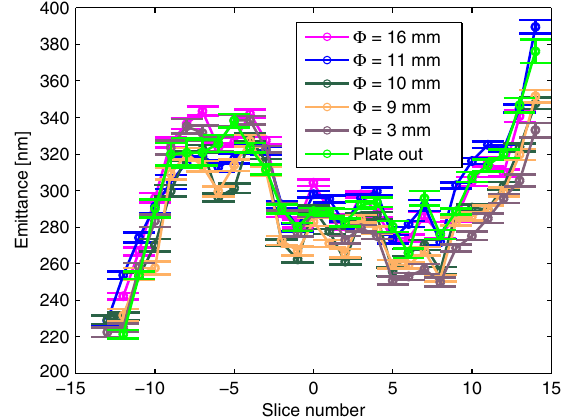
FIG. 22. Measured slice emittance along the bunch for the several diameter holes of the low energy collimator. The full bunch length is divided in 15 parts of constant size (not a constant charge per slice).